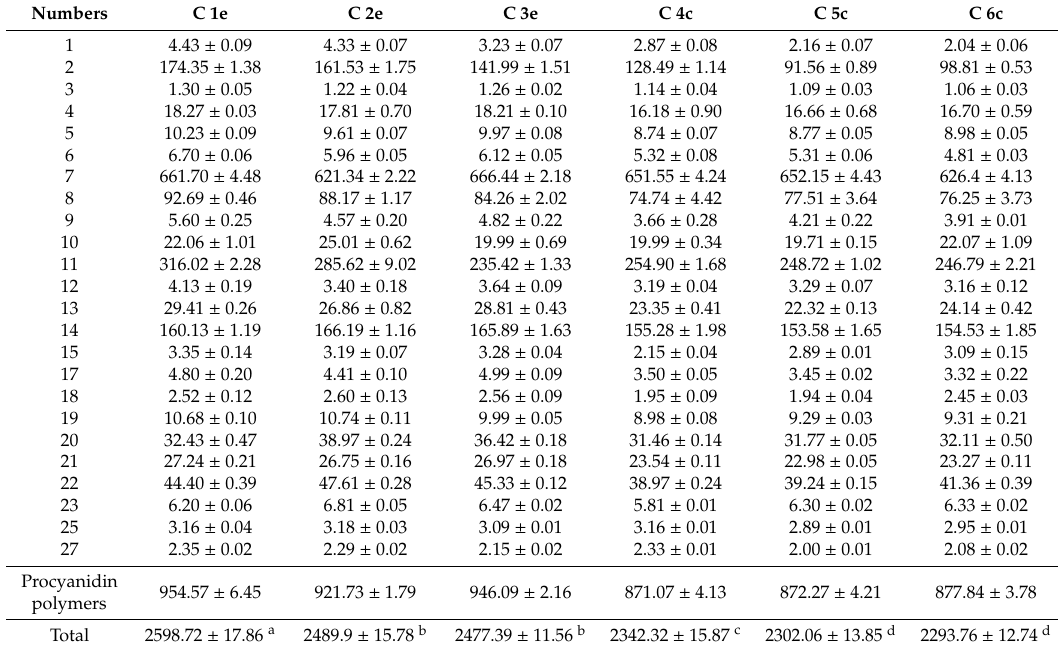
Table 5. Comparison of phenolic compounds detected in black chokeberry fruits [mg / 100g